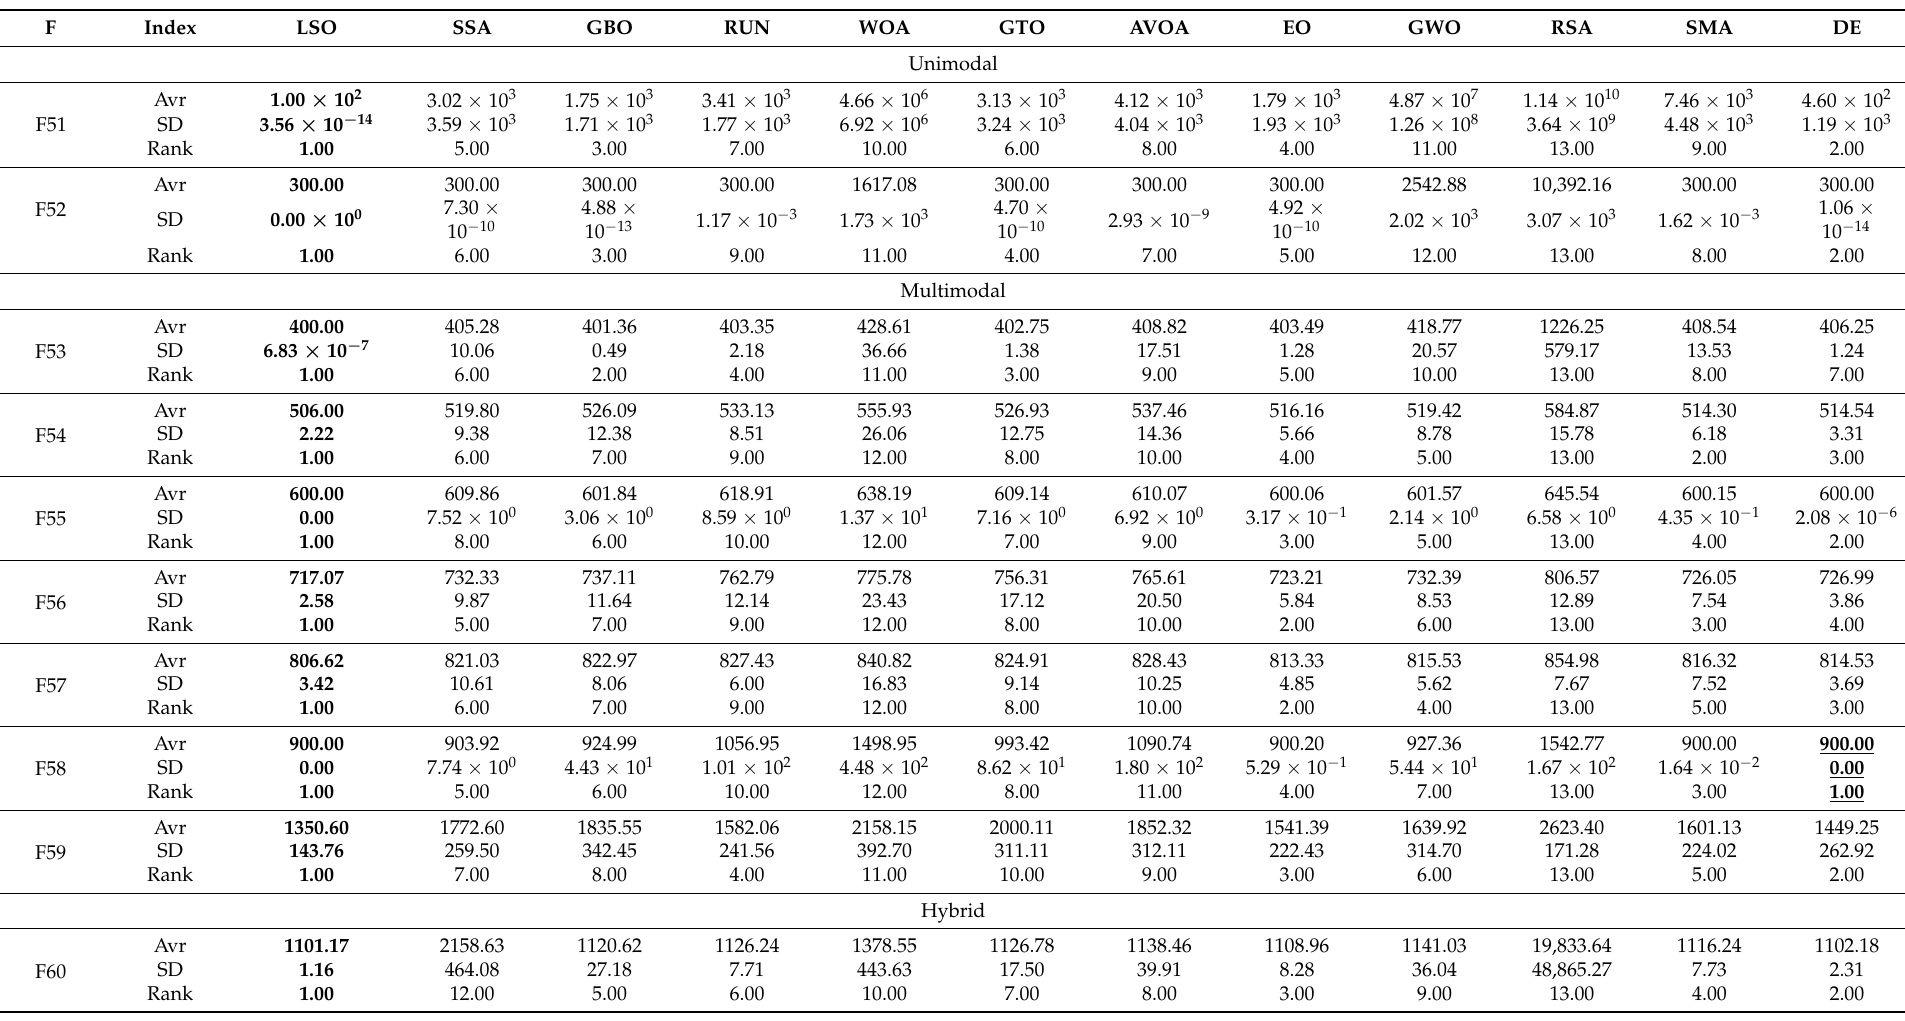
Table 10. Avr and SD of CEC2017 for 25 independent runs (The bolded value is the best